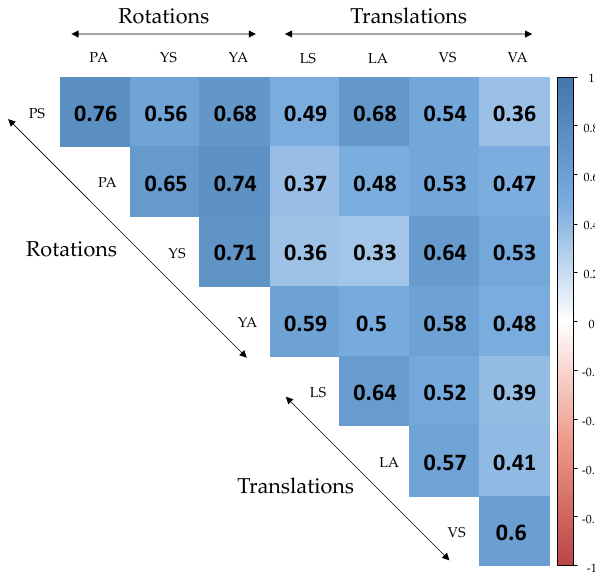
Figure 4. Correlation matrix between the experimental conditions. The numbers in each square represent Pearson’s R coefficient. Each square was clustered and ordered by hierarchical cluster analysis.